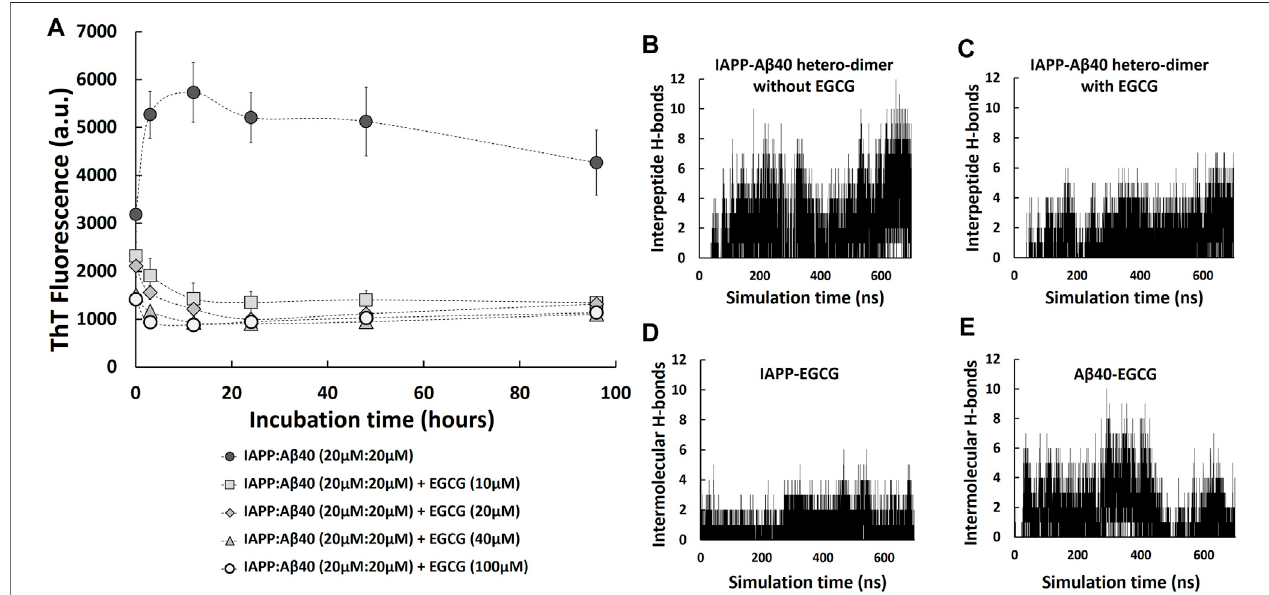
FIGURE 6 | IAPP-A β 40 co-aggregation kinetic pro fi les in the absence and presence of EGCG. (A) IAPP-A β 40 (20 µM:20 µM) samples were co-incubated with increasingEGCGconcentrations(10,20,40,and100 µM)andattheindicatedtime-points,theThT fl uorescencemeasurementswereacquired.Datarepresentmean± SE( n =3).Timeevolutionofinter-peptidehydrogen bondsformedbetweenIAPPandA β 40intheabsence (B) andpresence (C) of fi veEGCGmolecules.Timeevolution of inter-molecular hydrogen bonds formed between the fi ve EGCG molecules and each of IAPP (D) and A β 40 (E) in the hetero-dimer system.